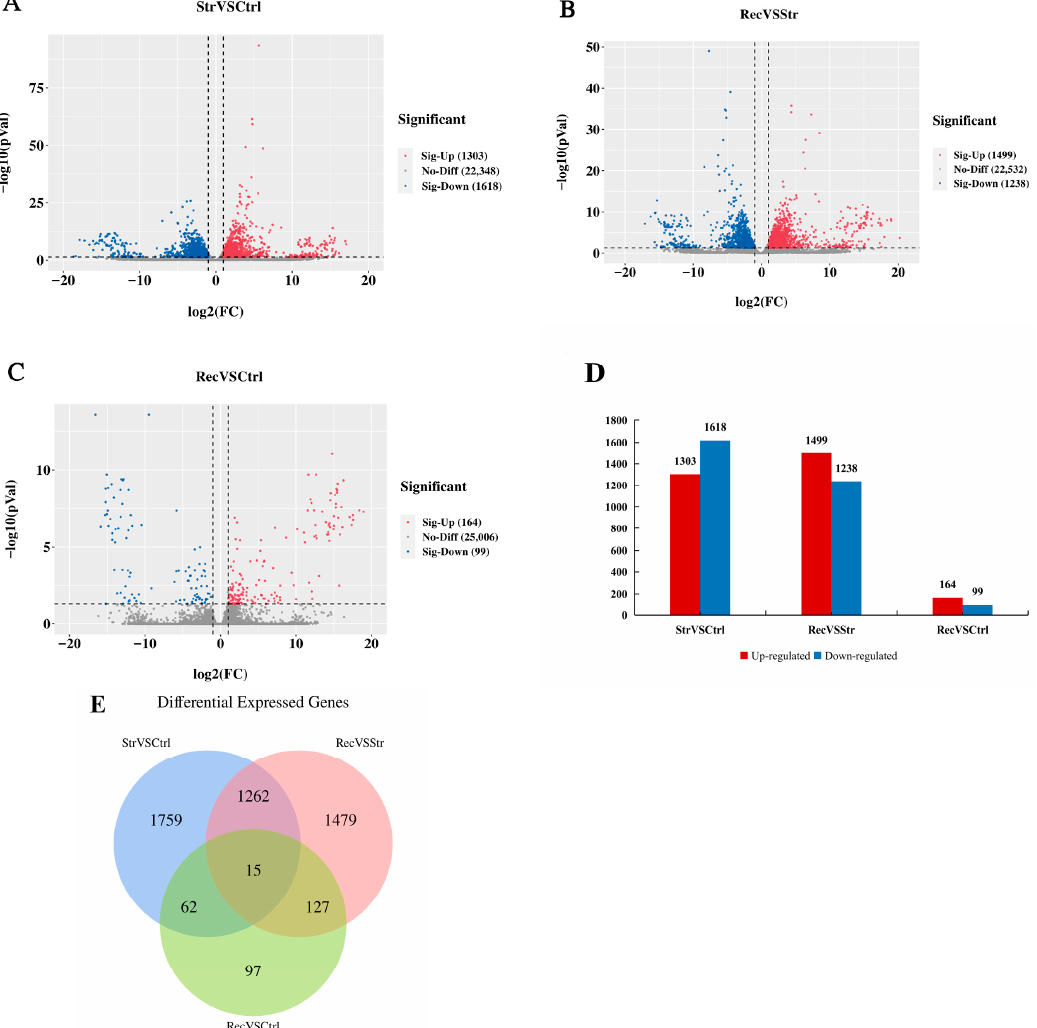
Figure 3. ( A ) Volcano plot of DEGs in StrVSCtrl (transport 16h group vs. control group). ( B ) Volcano plot of DEGs in RecVSStr (recovery group vs. transport 16h group). ( C ) Volcano plot of DEGs in RecVSCtrl (recovery group vs. control group). Gray dots represent genes showing no significant differences in expression. Red and blue dots represent significantly up-regulated and down-regulated DEGs, respectively. ( D ) Transcriptome analysis of the number and expression of DEGs. ( E ) Venn diagram of the number of DEGs.